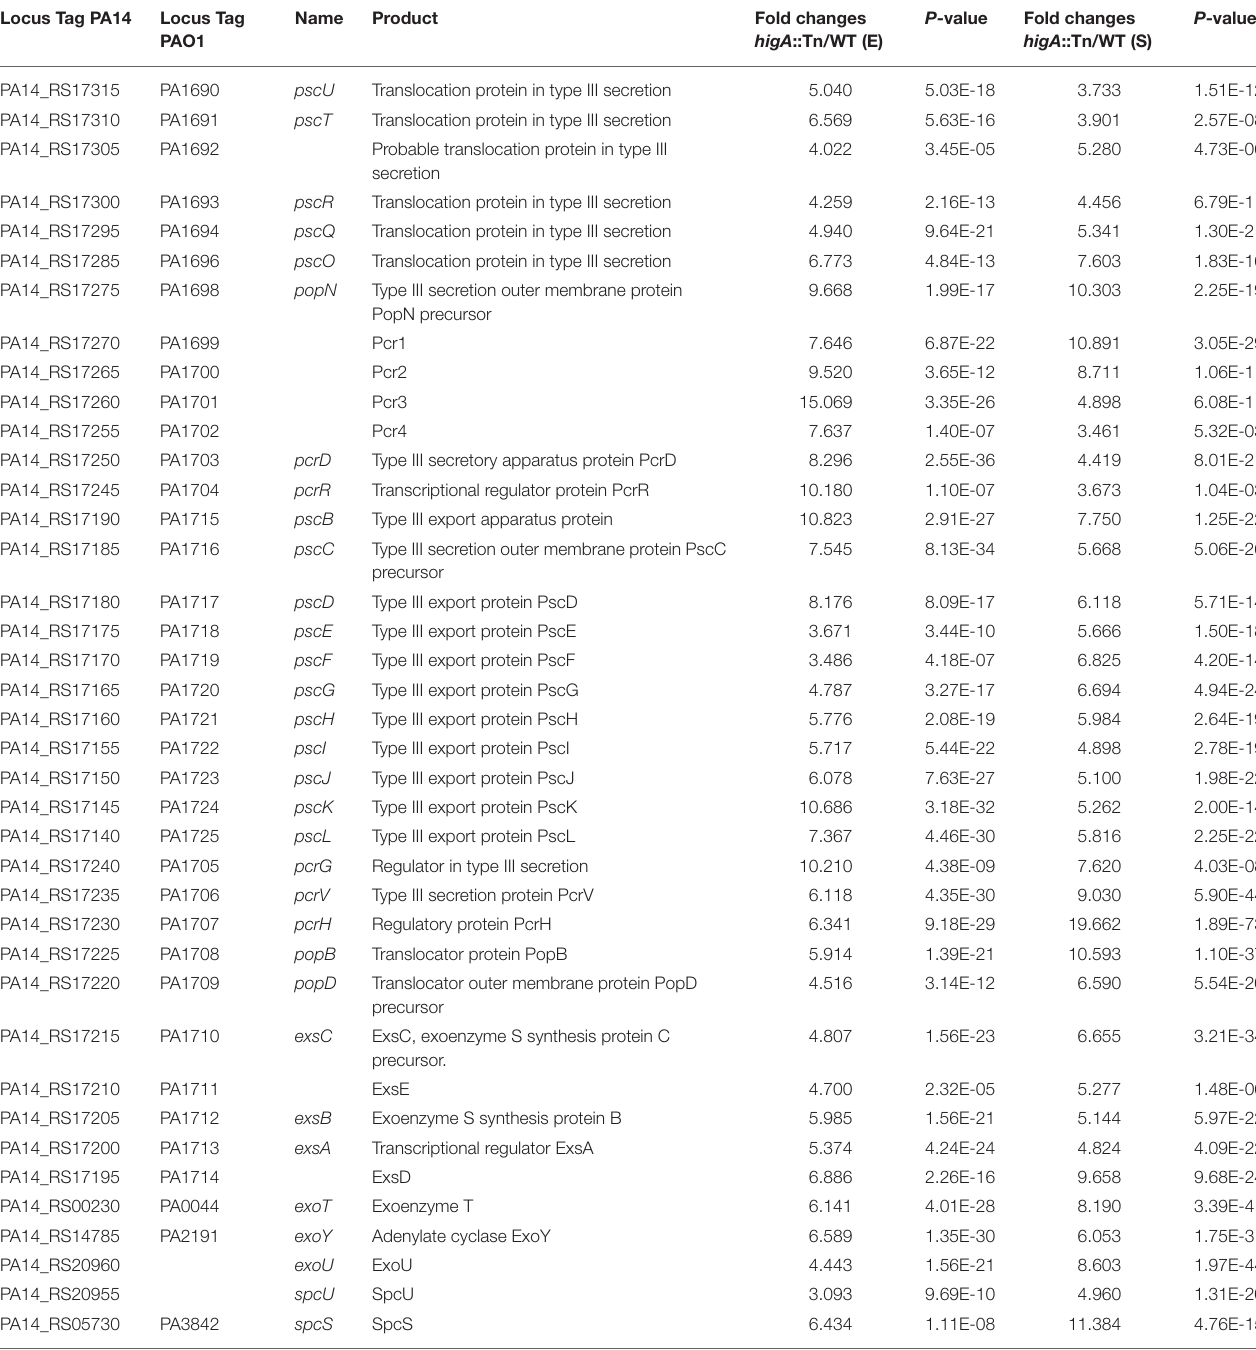
TABLE 1 | mRNA levels of T3SS genes in the higA ::Tn mutant compared to those in wild type PA14. Locus Tag PA14 Locus Tag Name Product Fold changes PAO1